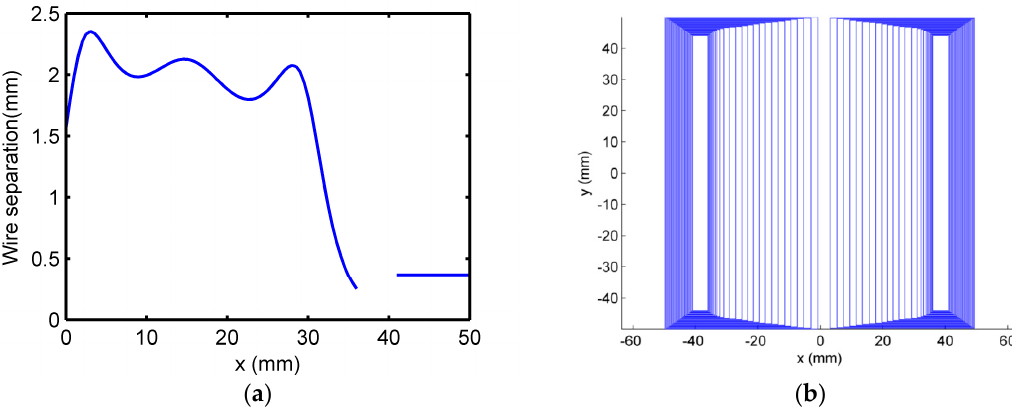
Figure 6. Optimized coil design 50 turns non-uniform distributed wires: ( a ) wire separation ( d w ) vs. x and ( b ) top view of the optimized coil.